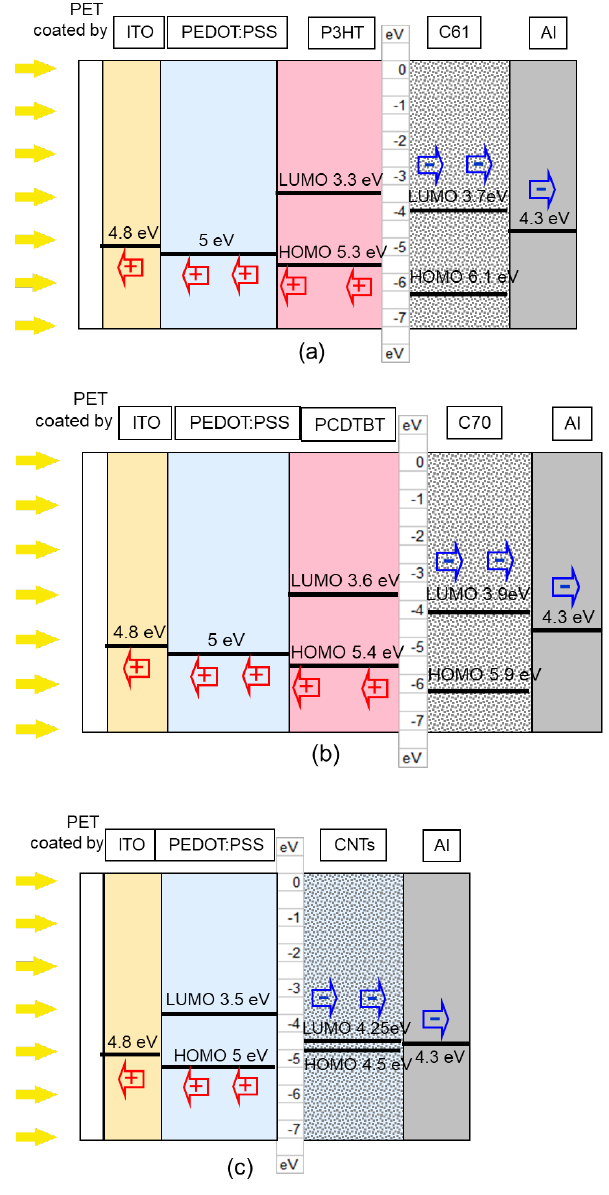
Figure 1. Energy level diagrams of different PV cell designs and flow of the positive and negative charge carriers. ( a ) typical ITO/PEDOT:PSS/P3HT/C 61 /Al, ( b ) ITO/PEDOT:PSS/PCDTBT/C 70 /Al, ( c ) ITO/PEDOT:PSS/CNT/Al